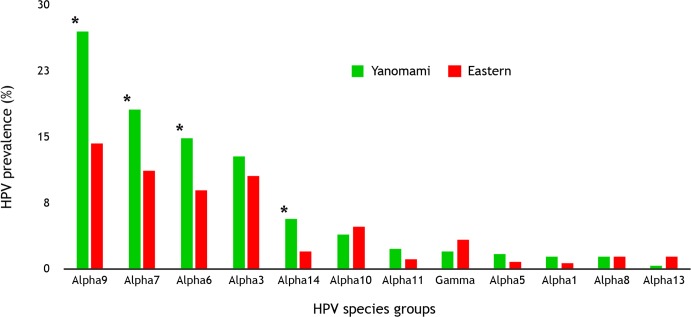
HPV prevalence by HPV species groups.*significative difference of prevalence of HPV between ethnic groups (p<0.05).